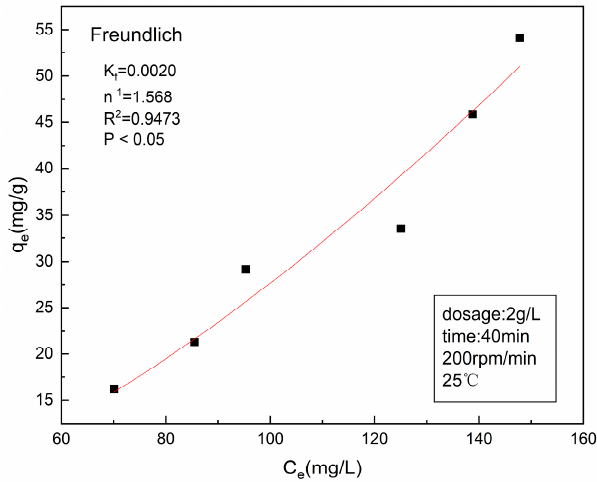
Figure 3. Non − linear Freundlich adsorption isotherm. Figure 3. Non-linear Freundlich adsorption